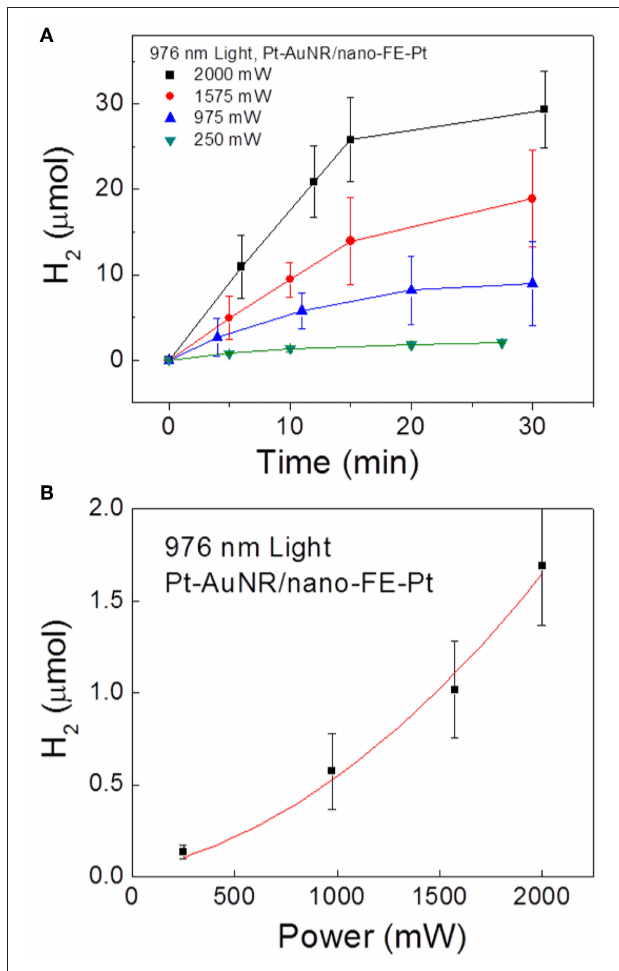
FIGURE 12 | Photocatalytic H 2 gas production on Pt-AuNR/nano-PT particles under 976nm light at power densities of 250, 975, 1,575, and 2,000 mW. (A) Measured H 2 production vs. time at the different irradiation powers, and (B) initial reaction rate vs. irradiation power. Figure adapted from Ortiz et al. (2018). Copyright 2018 American Chemical